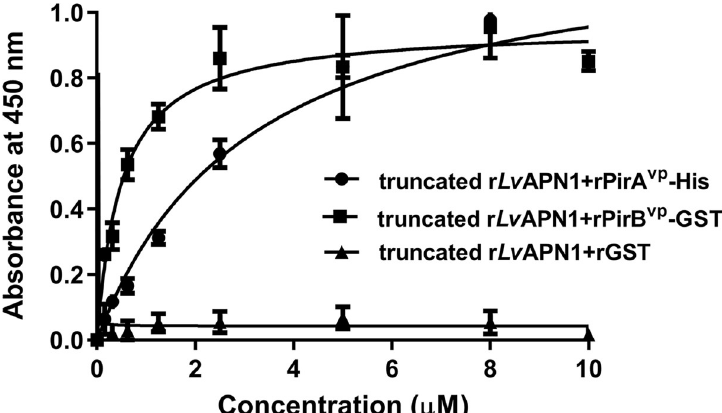
Fig 6. Binding ability of rPirA vp and rPirB vp on immobilized recombinant truncated Lv APN1-His determined by ELISA. The purified rPirA vp -His, rPirB vp -GST or rGST (0–10 μ M) was added to a purified recombinant truncated Lv APN1-coated plate, followed by probing with the anti-PirB vp specific primary antibody and goat anti-rabbit- conjugated HRP secondary antibody. Finally, after addition of the tetramethylbenzidine (TMB) substrate, the absorbance at 450 nm (A 450 ) was measured. Solid lines illustrate the fitted curves. The data are shown as the mean ± 1 Standard error of mean (SEM), derived from triplicate experiments.